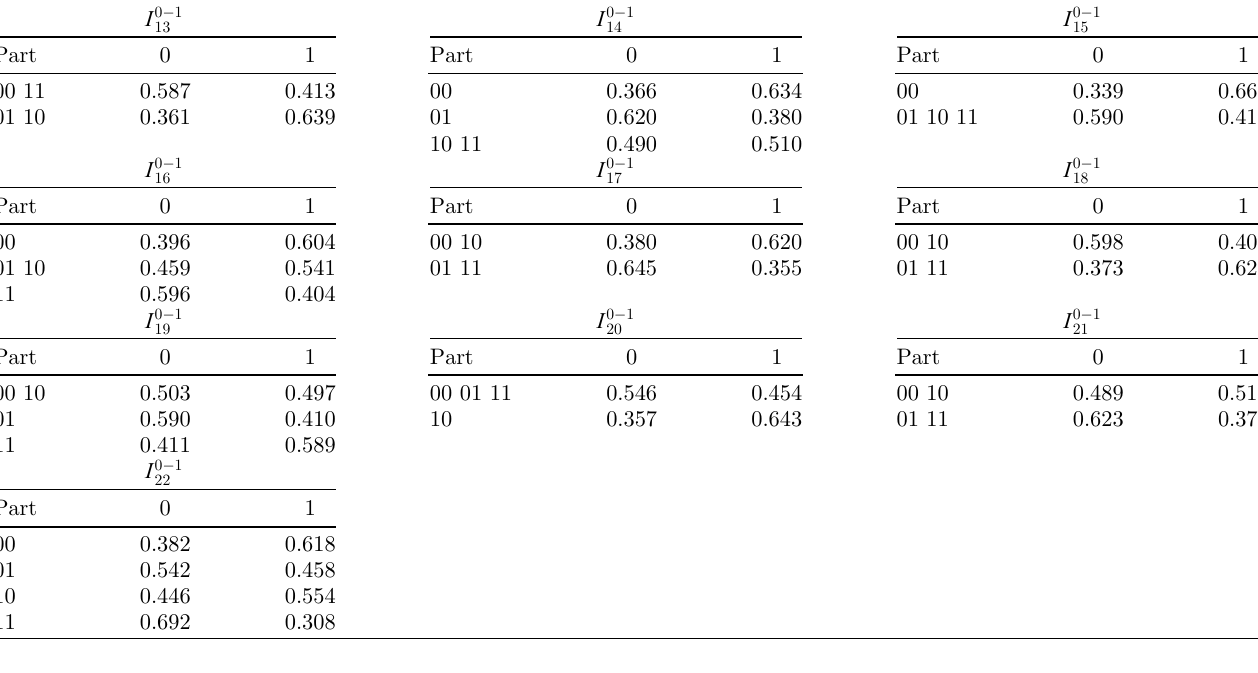
, i = 13, .. . , 22, see equation (5) and Remark i